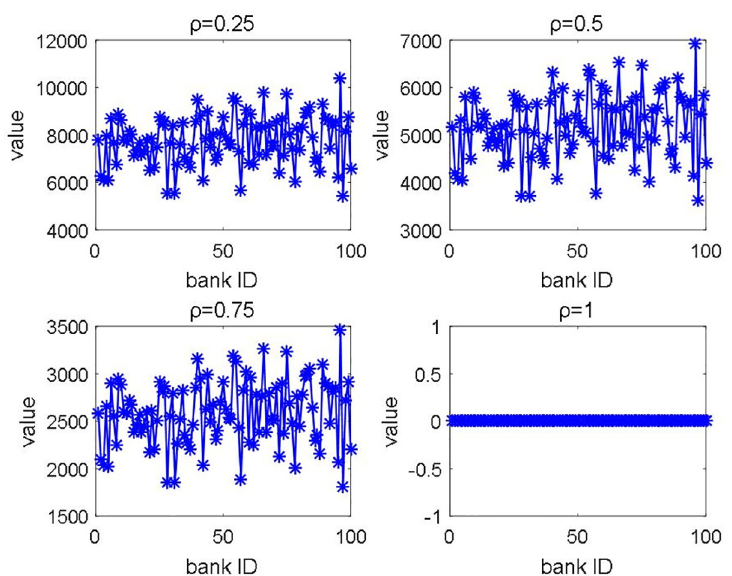
Fig 16. The sensitive analysis of